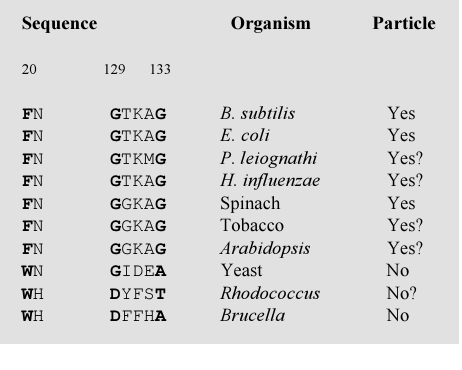
Figure 4 - Structural basis for the use of Brucella lumazine syn- thase as a carrier for displaying other immunogenic peptides from bacterial proteins. The a - carbon backbone of the penta- mer (light grey) and the structur- ally defined N-terminal residues of each monomer (dark grey) are